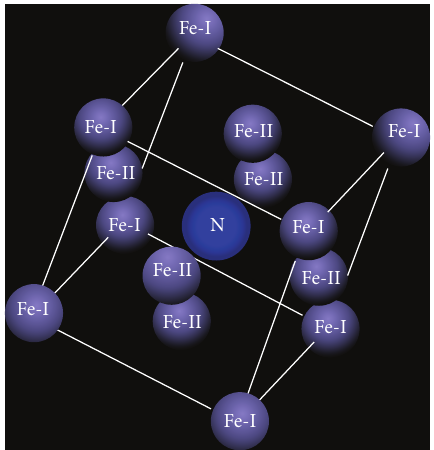
Figure 1: Unit cell structure of 𝛾 󸀠 -Fe 4